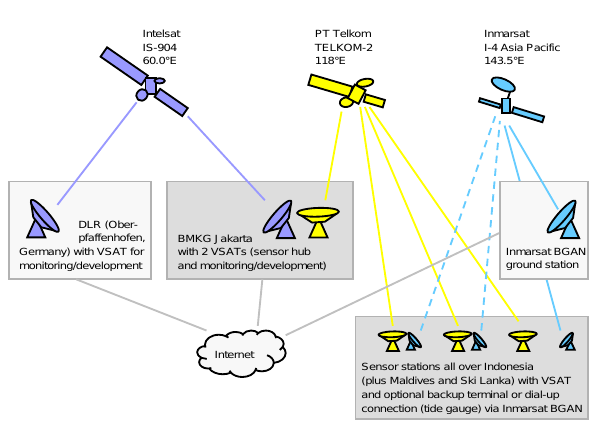
Fig. 6. Remote sensor stations of the GITEWS monitoring network in Indonesia.